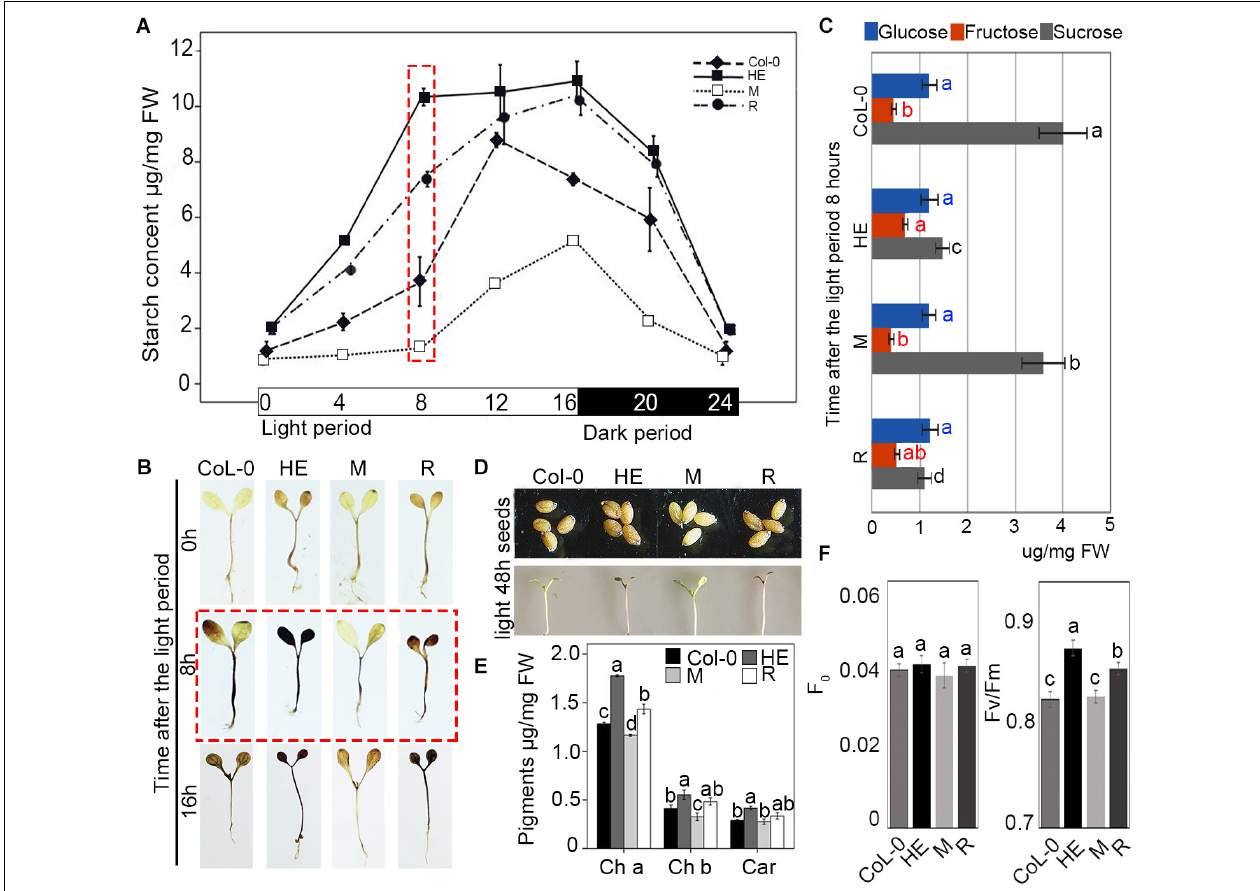
FIGURE 5 | EsNAC1 was involved in the accumulation of starch and pigment. (A) Changes in starch content in Col-0 and HE, M and R lines. The rosette leaves were collected at 0, 4, 8, 12, 16, 20 (4 h after dark period), and 24 h (8 h after dark period) in the light/dark cycle. (B) Staining results with Lugol’s solution at 0, 8, and 16 h of the light period. (C) The concentrations of glucose, fructose, and sucrose in Col-0 and HE, M and R lines at 8 h of the light period. (D) The phenotypes of seeds and seedlings 5 days after sowing after 48 h of light. HE and R lines showed the accumulation of anthocyanin. (E) Contents of chlorophyll a and b and carotenoids in Col-0 and HE, M and R lines. (F) F 0 and F v / F m in Col-0 and HE, M and R lines. Fv, maximal fluorescence; Fm, variable fluorescence. Values represent the mean ± SD, and those labeled with a letter are significantly different at P < 0.05 by Duncan’s test. Three biological replicates were in the experiment, with each biological replicate with 20 or 8 (for F 0 and F v / F m , respectively)